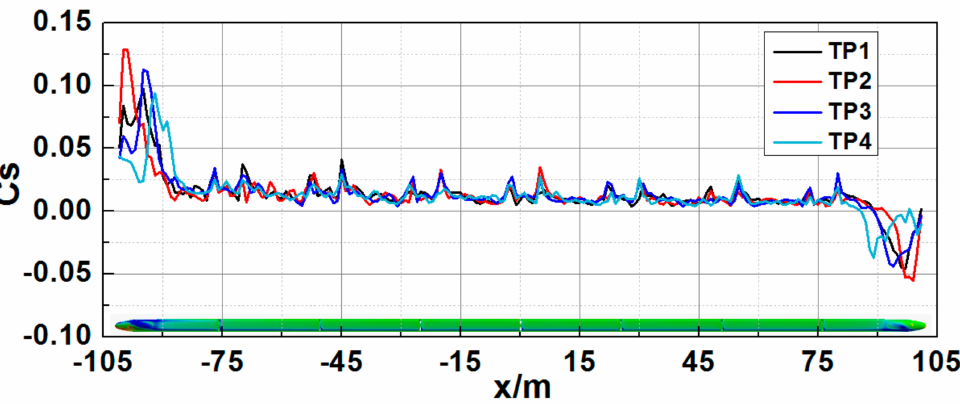
Figure 19. Curves of accumulated Cs at t = 2